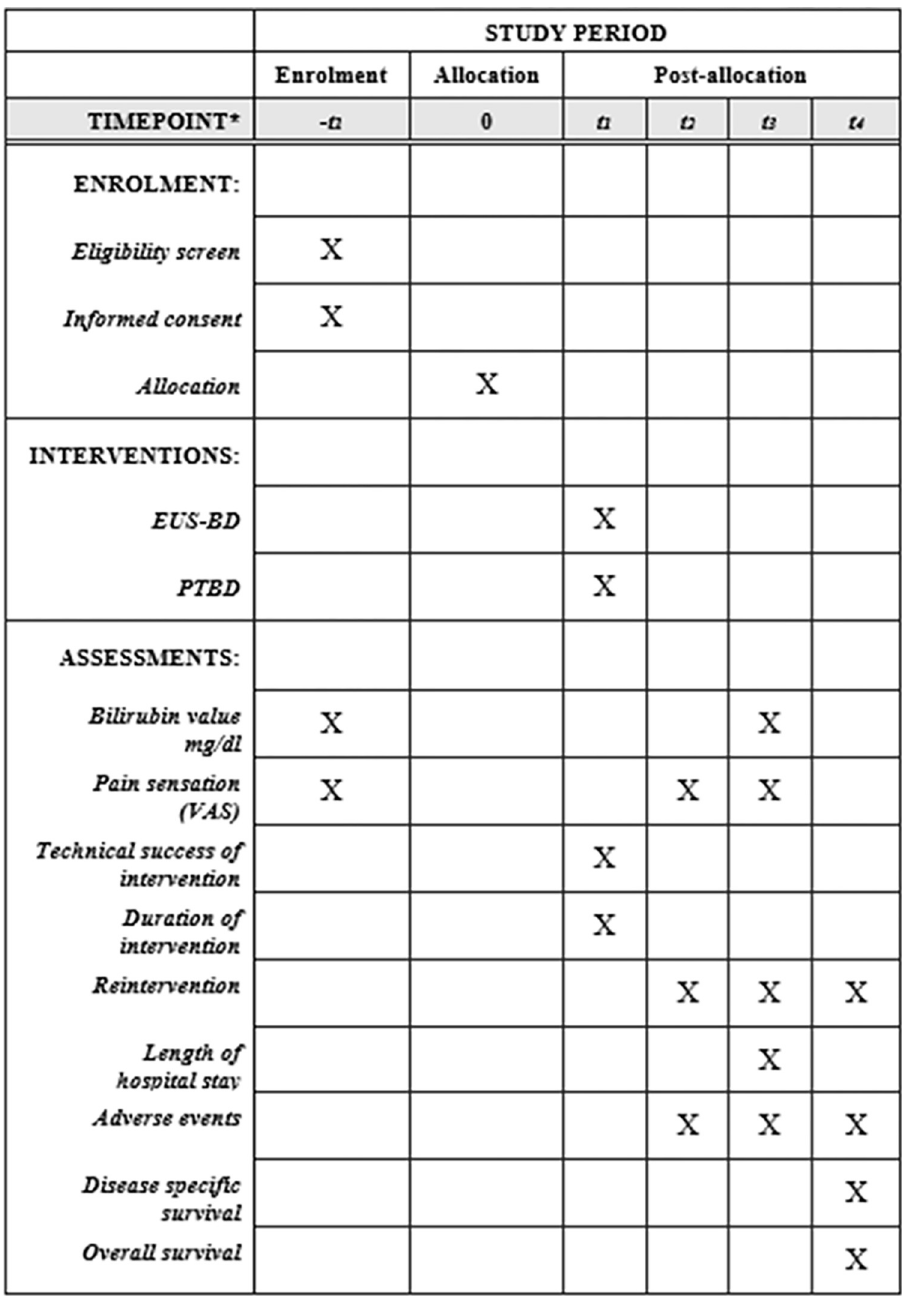
• Clinical success, defined as the reduction of the serum bilirubin value of � 50% in 7 days • Occurrence of AEs (including death) within 30 days after the intervention